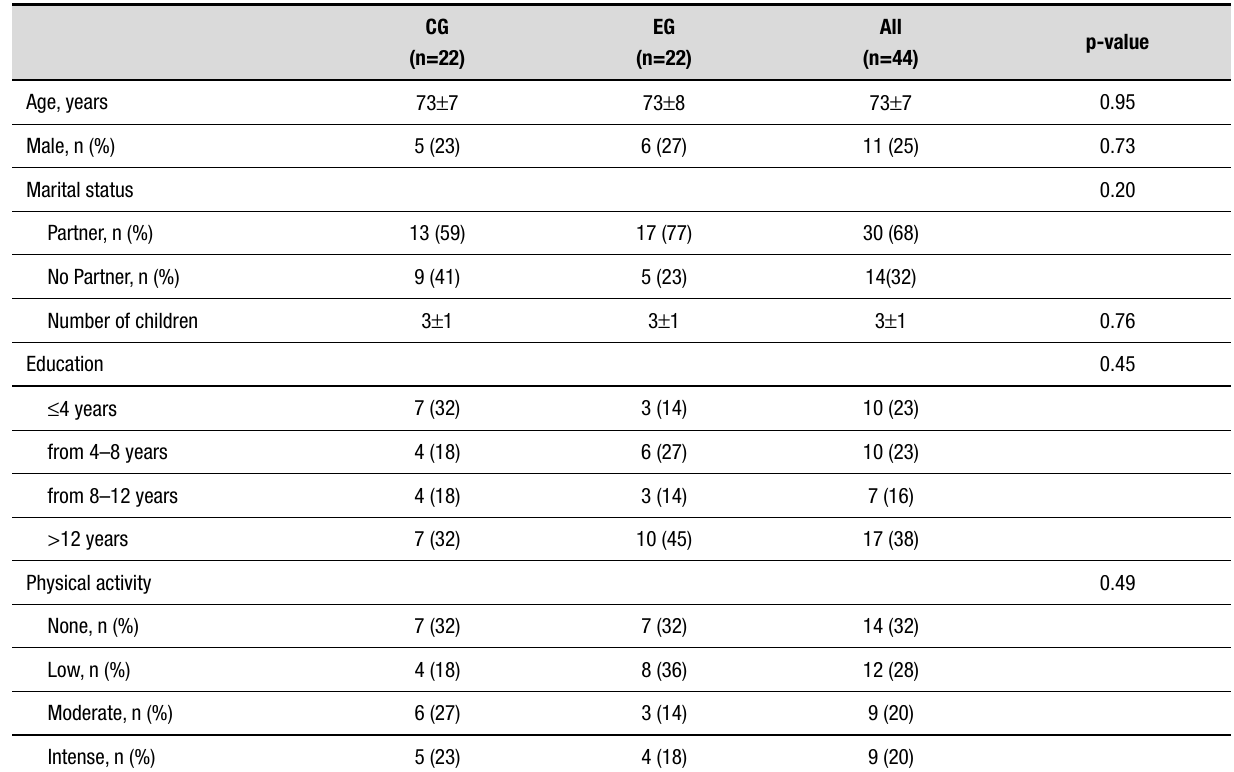
Table 1. Sociodemographic data of the sample.